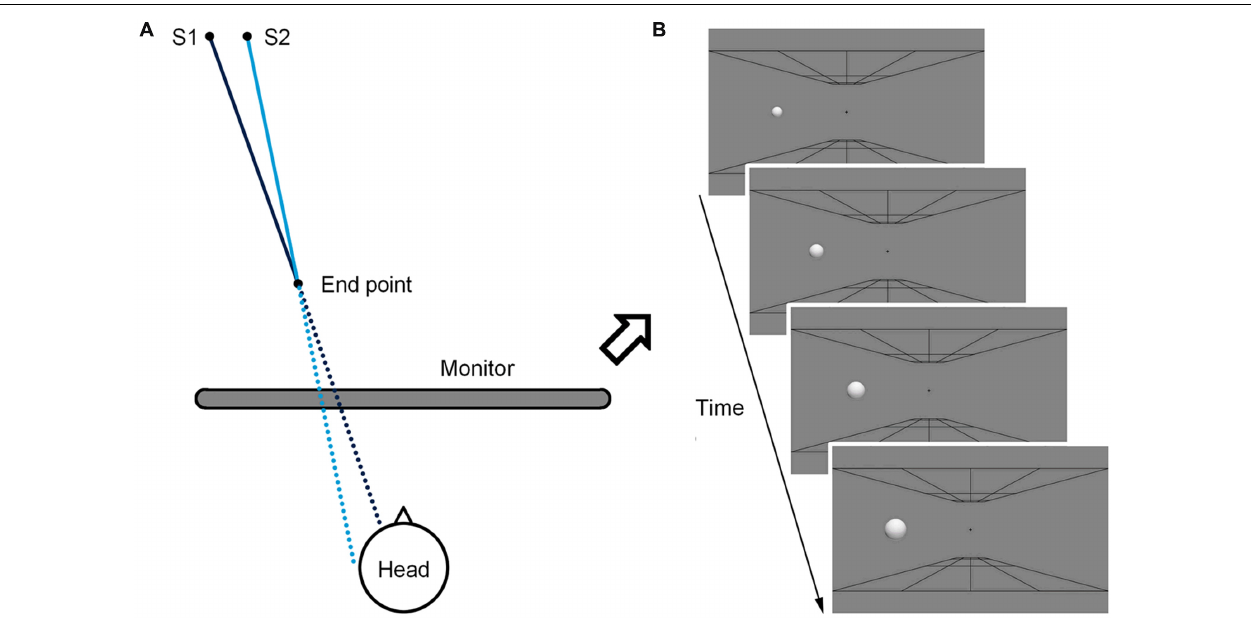
FIGURE 1 | Illustrations of the simulated motion trajectories of the spheres in three-dimensional coordinates (A) and on the screen (B) . The dark blue line represents the collision path and the light blue line represents the near-miss path. The solid lines are the simulated trajectories of the spheres moving from 350 cm to 150 cm from the observers, and the dashed lines are the imaginary trajectories if the spheres continue to move after stillness. S1 and S2 are the simulated start locations of the collision and the near-miss spheres,